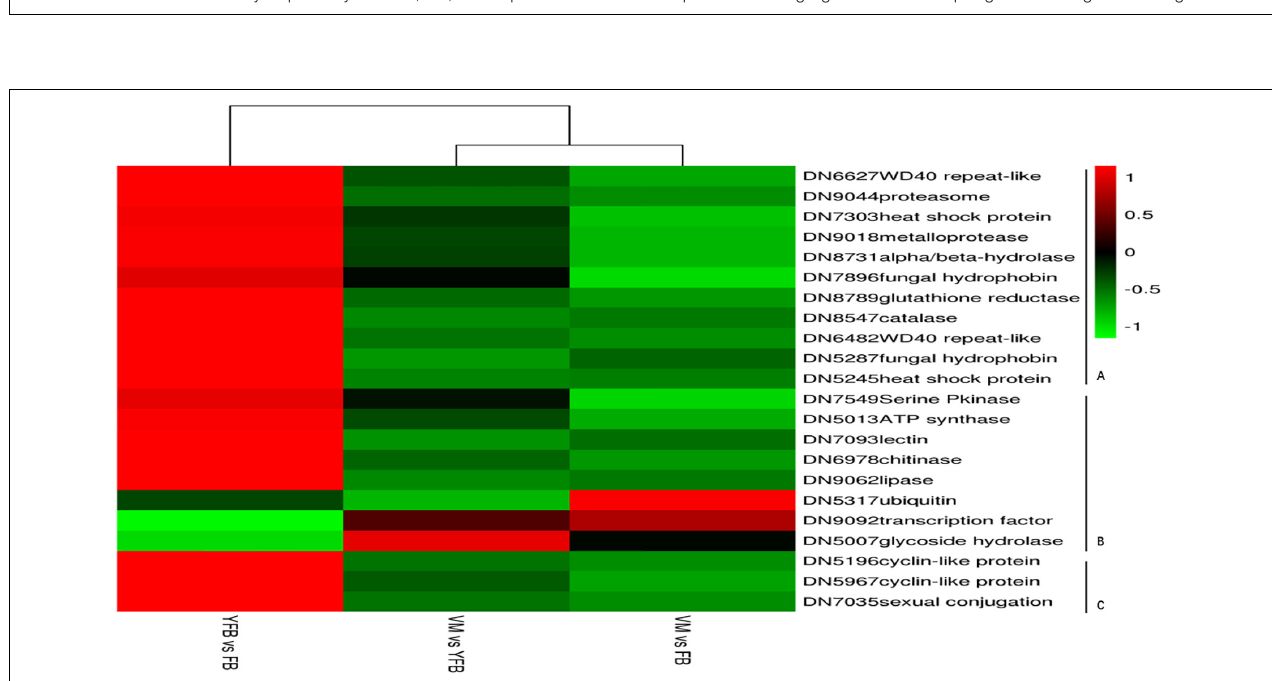
FIGURE 5 | qRT-PCR validation of DEGs. The 18S gene was selected as the internal control in this study. The expression patterns determined by qRT-PCR were consistent with those obtained by RNA-Seq, thus confirming the reliability of our RNA-Seq data. (A) Eleven environment-related DEGs were analyzed by qRT-PCR. (B) Eight growth and development-related DEGs were analyzed by qRT-PCR. (C) Three sex-related DEGs were analyzed by qRT-PCR.